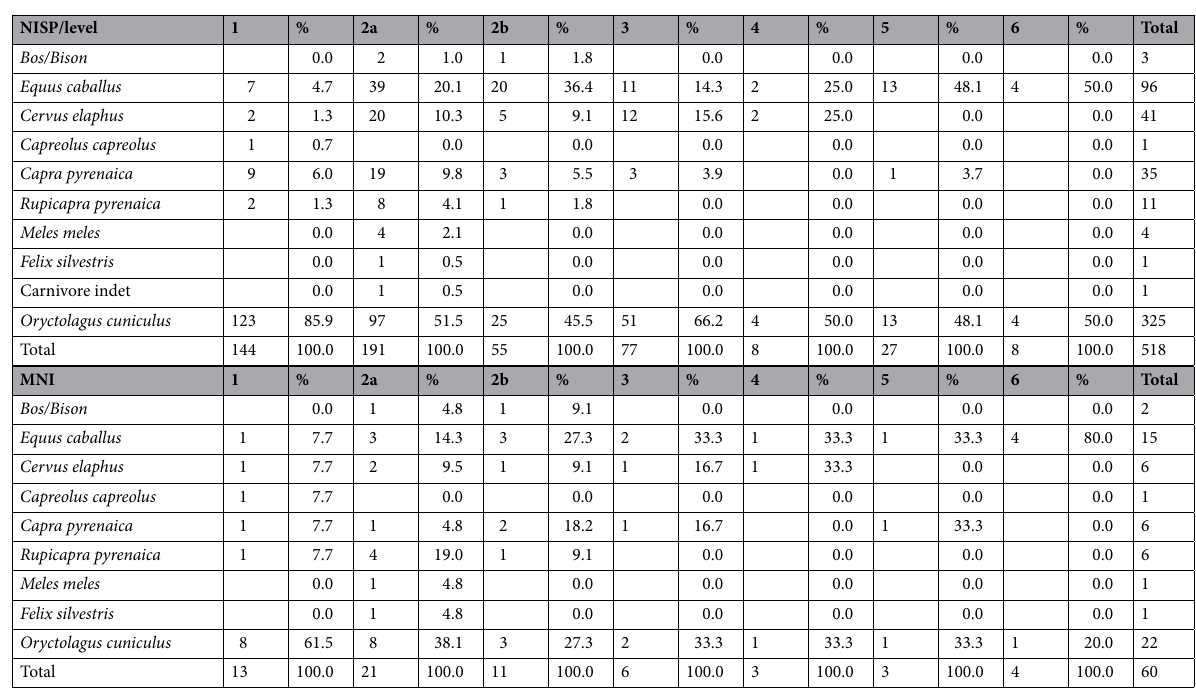
Table 5. Taxonomic representation of macrovertebrates remains at the Peña Capón sequence according to NISP and